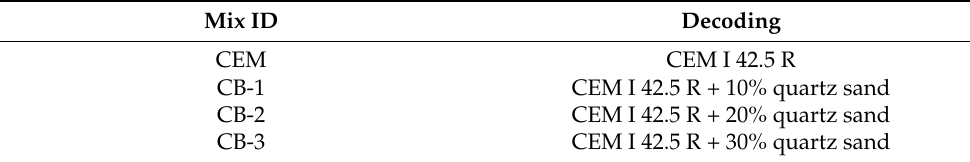
Table 2. Percentage addition of quartz sand to CEM I 42.5 R Portland